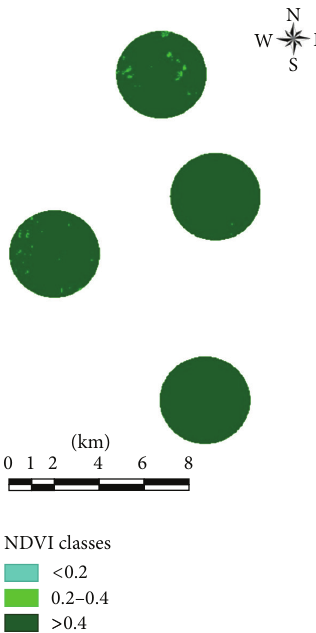
Figure 3: Vegetation density map in terms of NDVI classes in 5km buffer area surrounding the highest elevation points for 2005.